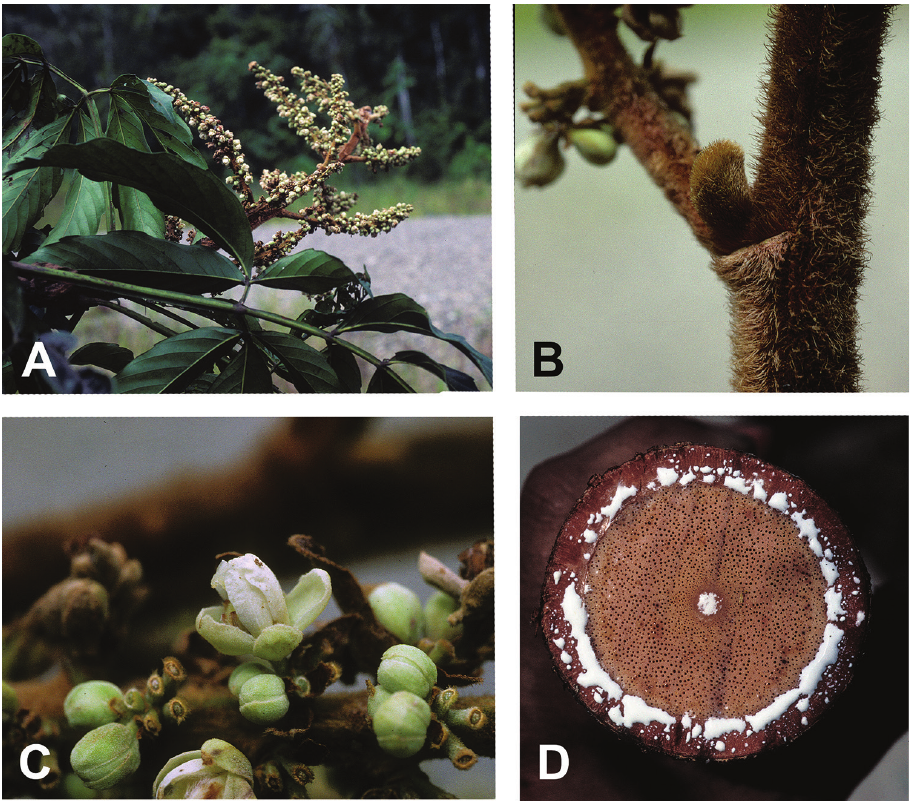
Figure 7. Paullinia wurdackii . A Flowering branch B Inflorescence axis with lanate indument and bul- bous axillary bud covered by cataphylls C Detail of inflorescence showing sessile cincinni and few remnant bracts D Cross section of stem showing regular anatomy and abundant milky latex emanating from the phloem and medulla. Photos by P. Acevedo, based on Acevedo-Rodríguez & Cedeño 7654 . deciduous stipules; and unwinged, woody fruits. Paullinia wurdackii however, is eas- ily recognised by its lanate or lanate-tomentose stems and inflorescence axes, the large bracts and overlapping bracteoles that enclose the cincinni and the sessile fruits. While P. ingifolia has a wide distribution that ranges from Costa Rica south to Bolivia,